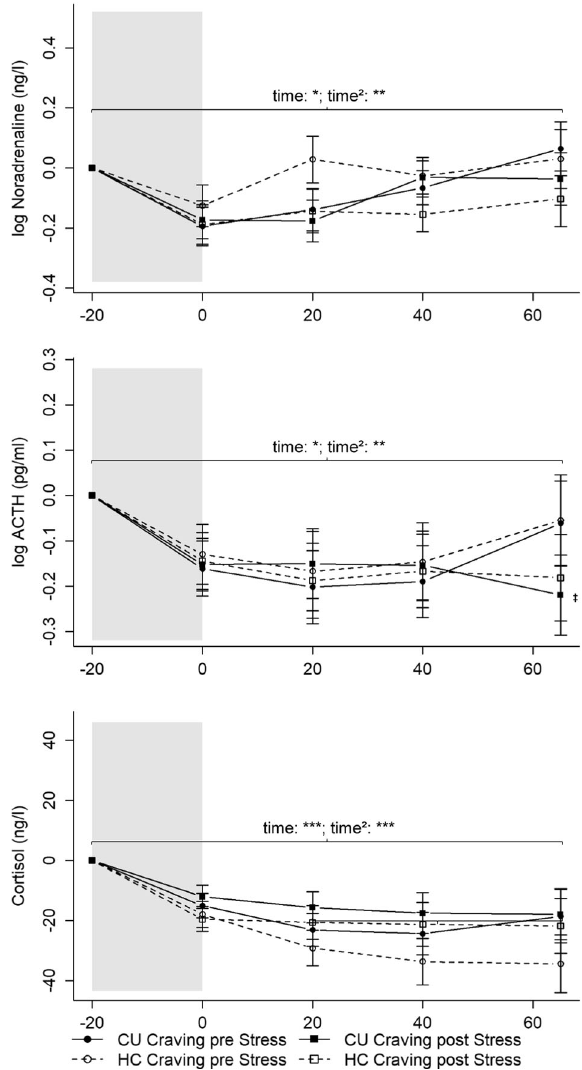
Fig. 5 Mean levels and standard errors of the mean for noradrenaline, ACTH, and cortisol during the Cocaine-Cue- Video. Gray shaded areas indicate the Cocaine-Cue-Video. Values were normalized by subtracting the stress levels measured at T 1 ( − 20 min) from all other values to facilitate interpretation of the stress reaction independently of effects of the circadian rhythm or baseline differences ( T 0 ). The Cocaine-Cue-Video did not induce a neuroendocrine stress response. CU = Cocaine users; HC = Healthy controls. CU Craving pre Stress: * p < 0.05; ** p < 0.01; *** p < 0.001; CU Craving pre Stress time 2 vs. CU Craving post Stress: ‡ p < 0.05. Noradrenaline: CU Craving pre Stress: n = 20; CU Craving post Stress: n = 21; HC Craving pre Stress: n = 17; HC Craving post Stress: n = 19. ACTH and cortisol: CU Craving pre Stress: n = 20; CU Craving post Stress: n = 22; HC Craving pre Stress: n = 17; HC Craving post Stress: n =